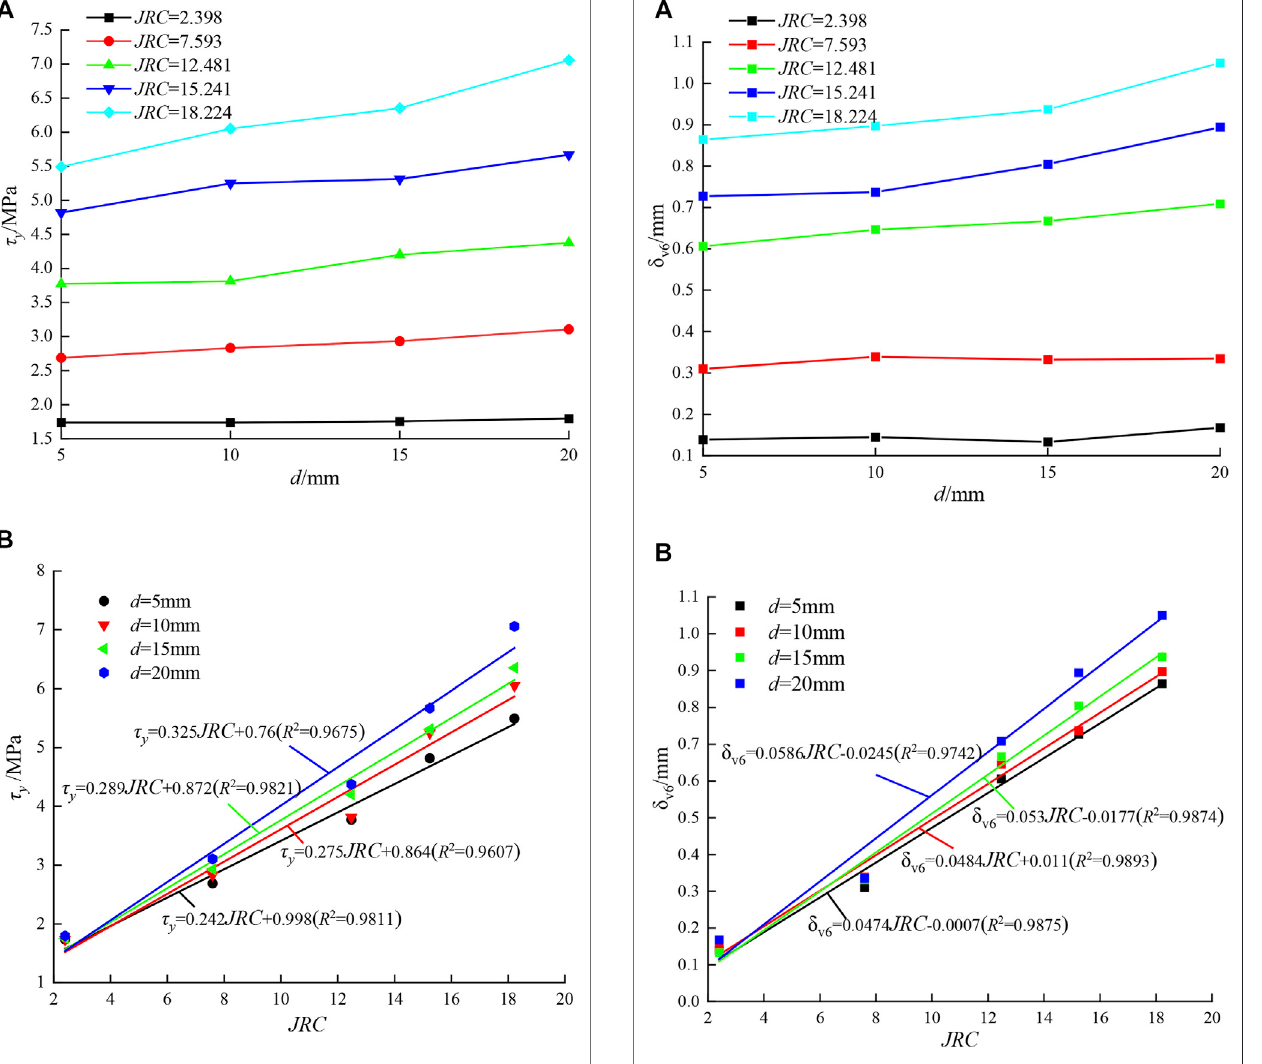
FIGURE 14 | Variation of δ v6 with d and JRC. (A) d - δ v6 . (B) JRC- δ v6